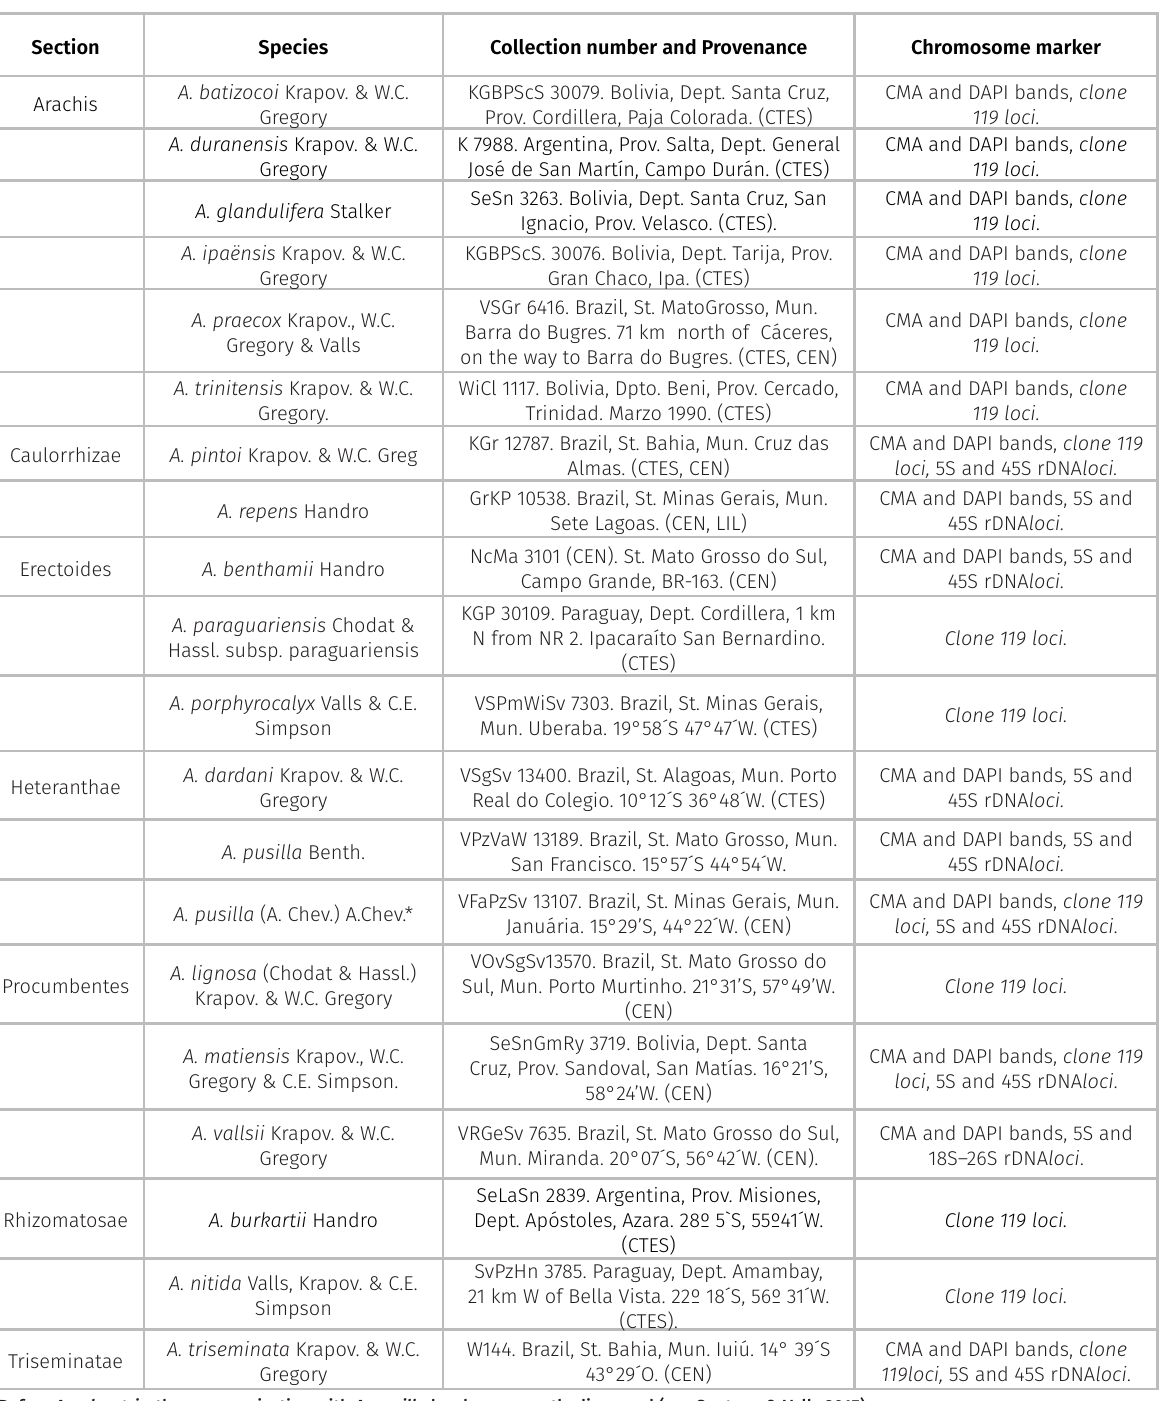
Table I. List of the Arachis species karyotypically characterized, collection number and provenance and chromosome marker